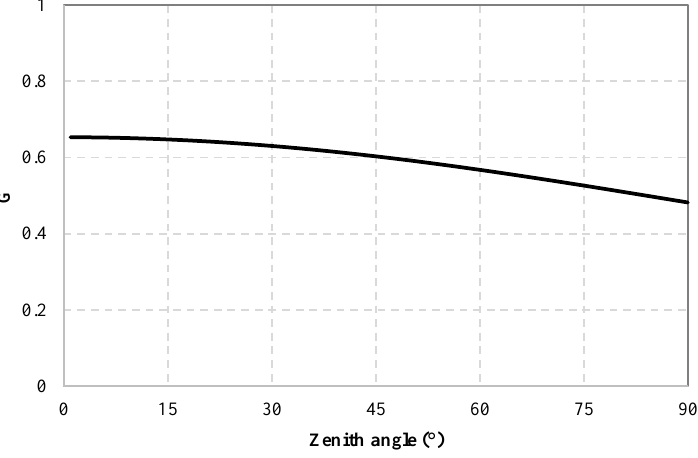
Figure 17. Relationship of the G function value with the zenith angle.